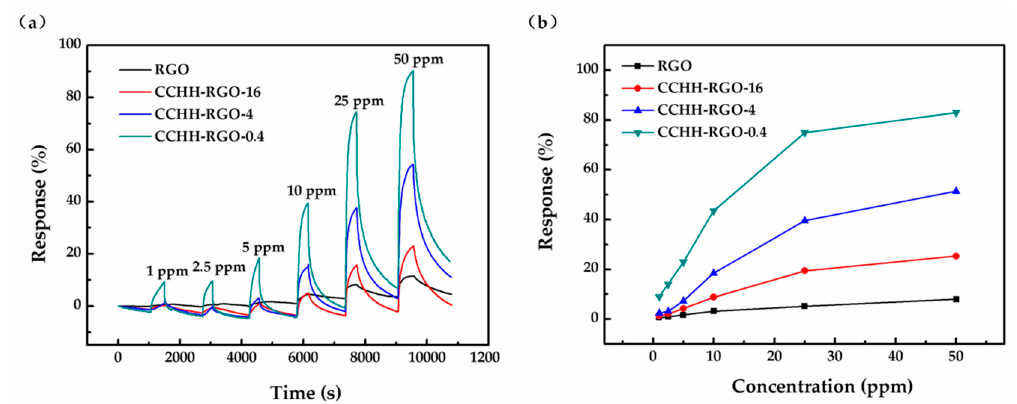
Figure 5. ( a ) Gas sensing response of four sensors under six different concentrations of ammonia; ( b ) Response with different concentrations of ammonia ranging from 1 to 50 ppm.